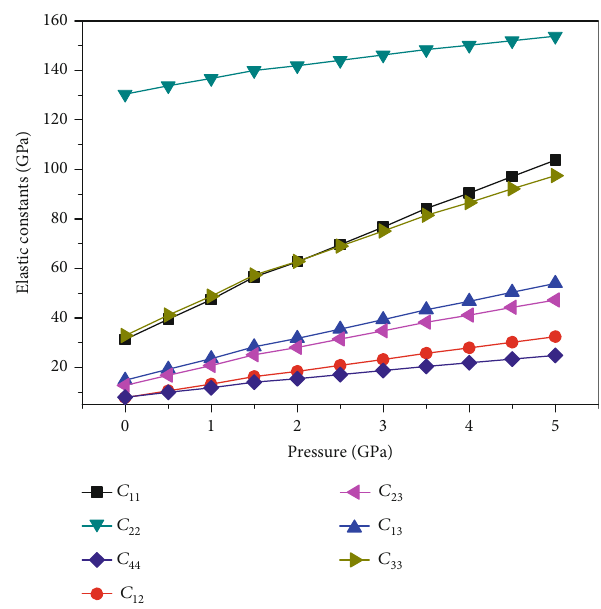
Figure 3: The elastic constants of orpiment As